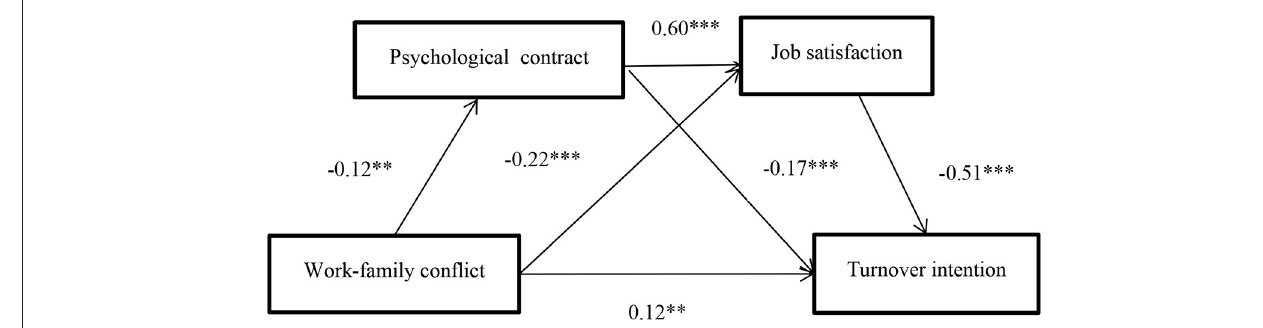
FIGURE 2 | Path analysis of Serial mediating effect. ** p < 0.01 and *** p < 0.001.